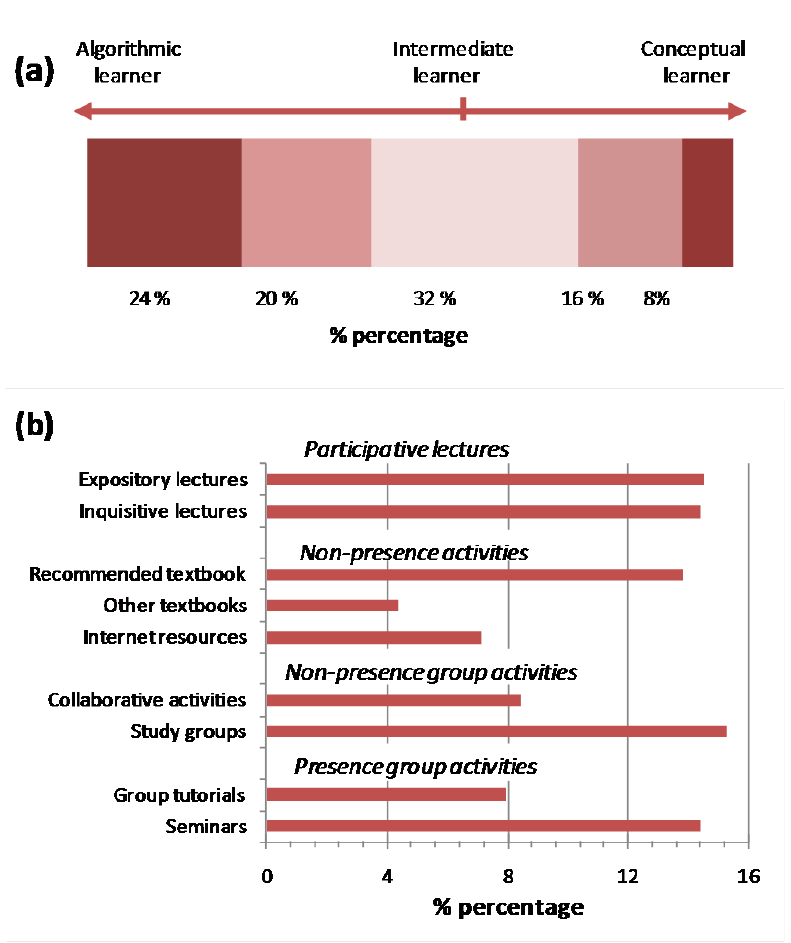
Figure 2. Survey results: (a) Auto-classifcaton of students according their cognitve development. (b) Relatve contributon of teaching-learning actvites on learning efciency for problem solving